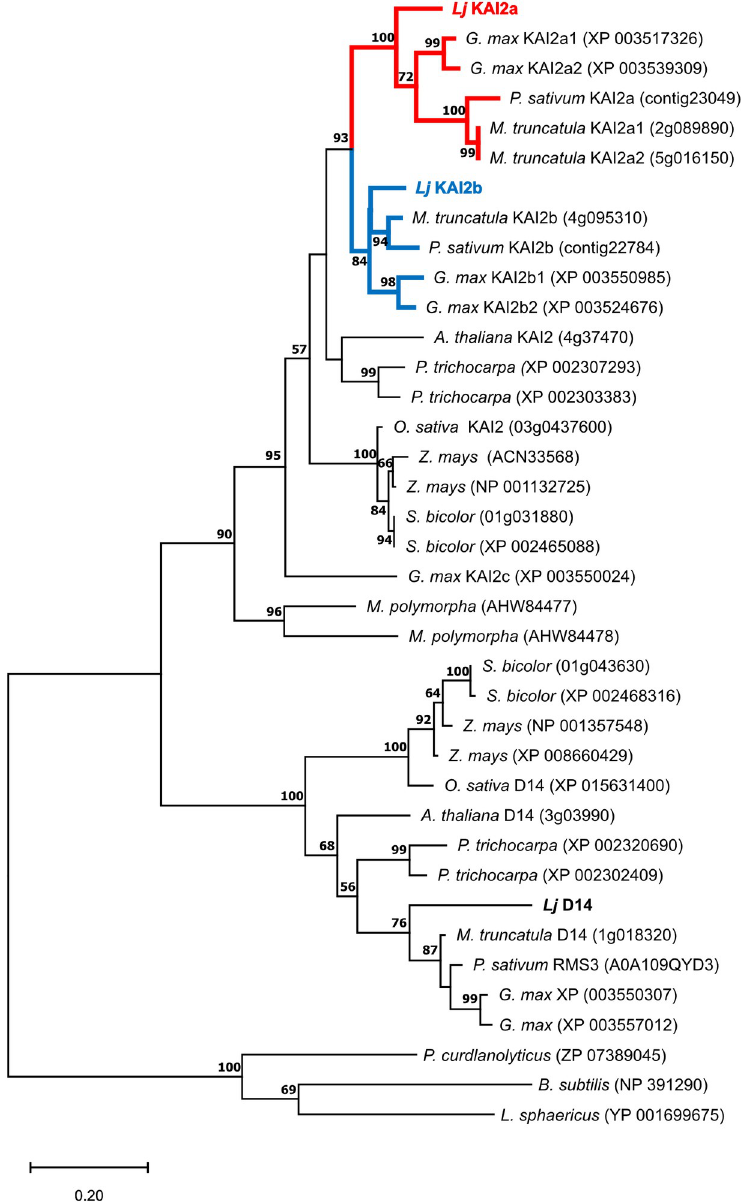
Fig 1. The KAI2 gene underwent duplication prior to diversification of the legumes. Phylogenetic tree of KAI2 and D14 rooted with bacterial RbsQ from indicated species ( Lotus japonicus; Glycine max; Pisum sativum; Medicago truncatula; Arabidopsis thaliana; Populus trichocarpa; Oryza sativa; Zea mays; Sorghum bicolor; Marchantia polymorpha ). MEGAX was used to align the protein sequences with MUSCLE and generate a tree inferred by Maximum Likelihood method [72]. The tree with the highest log likelihood (-7359.19) is shown. The percentage of trees in which the associated taxa clustered together is shown next to the branches. Values below 50 were ignored. KAI2 duplication in the legumes is highlighted by red and blue